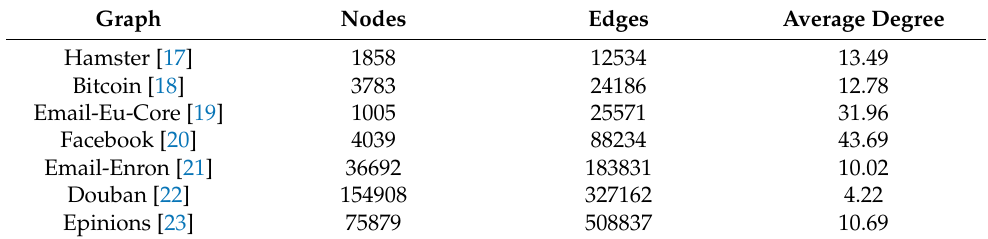
Table 1. Evaluated data sets. Graph